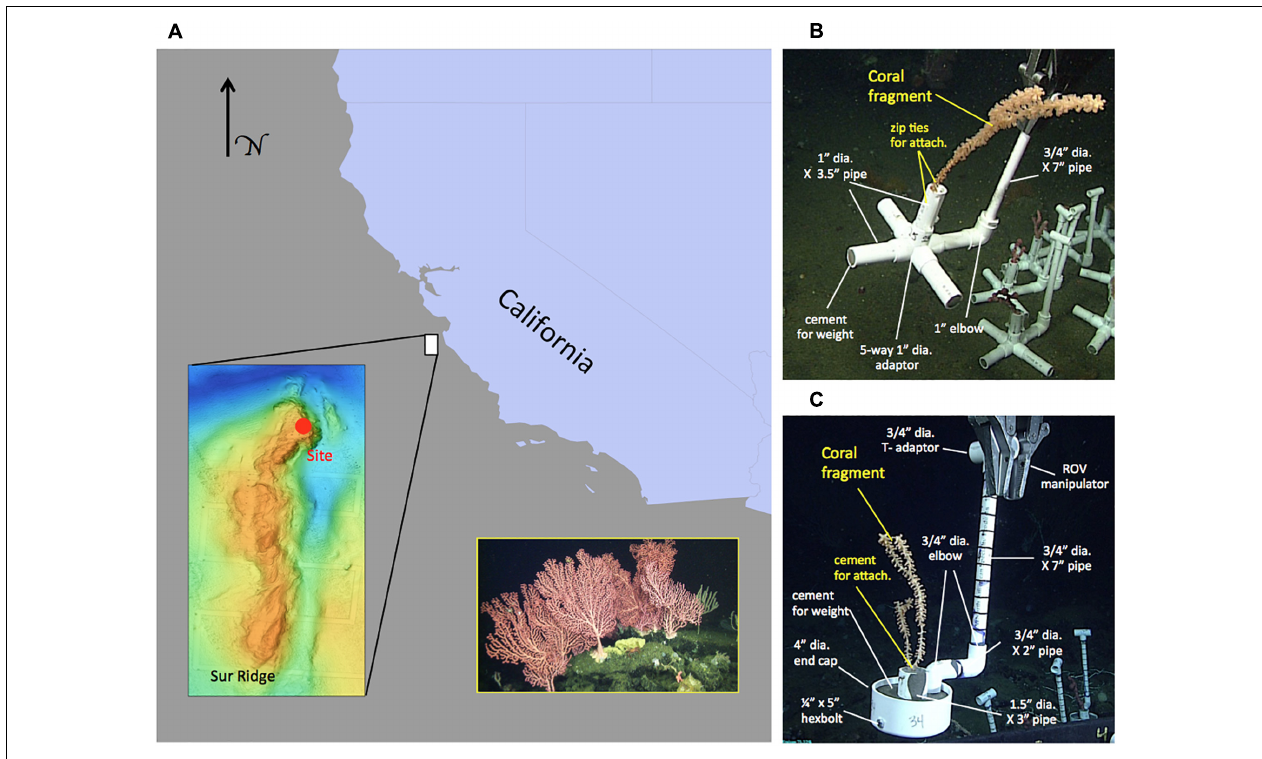
FIGURE 1 | Map of the study area and schematic of coral pots with different coral attachment methods. (A) Location of Sur Ridge with respect to California, United States coastline. Lower-left inset: multi-beam sonar map of Sur Ridge. Solid red circle in the sonar map indicates the general location of the study site. Lower-right inset: photograph of an example coral and sponge cluster in the study area taken from the ROV Doc Ricketts . (B) Example coral pot using the zip tie method for attaching coral fragments in a moveable module. These coral pots (v.1) were also used with the cement attachment method (sans zip ties) in follow-up deployments. (C) Example coral pot v.2 using the cement attachment method for attaching a coral fragment in a moveable module. Note: all coral pot materials are Schedule 40 standard poly vinyl chloride (PVC) with the exception of the cement and galvanized steel hexbolt and